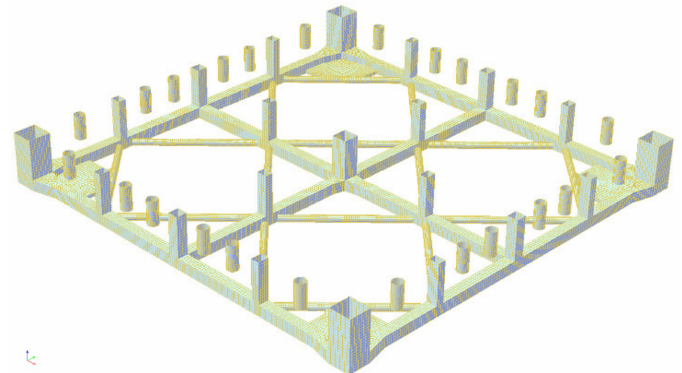
Figure 5. Panel model of the large semi-submersible structure.